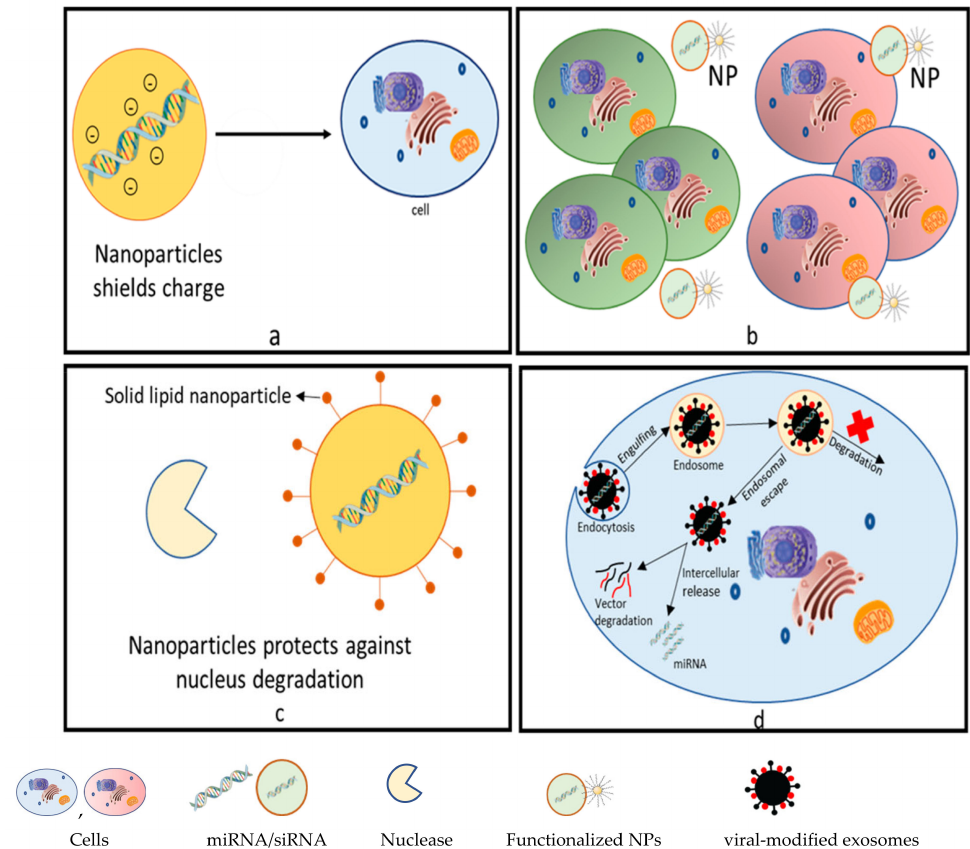
Figure 5. Illustration of dendritic molecular structures with a central core, repeating branches, and terminal reactive functional groups. They can be classified as polymers and hyperbranched poly- Figure 6. Advantages of nanoparticles. ( a ) Nanoparticles (NPs) encapsulate miRNA/SiRNA, thus mers with convergent and divergent architectures, depending on their molecular nature weight. Their nanostructure provides dendrimer–drug conjugation via different interactions such as elec- shielding the charges and improving the penetration/uptake of cells. ( b ) Functionalized NPs (meso- trostatic and hydrophobic/hydrogen bonds or the capacity for drug encapsulation within the central porous silicon) enable controlled and cell-specific miRNA/siRNA delivery. ( c ) Solid lipid nanoparti- cavity and/or between the dendrons (branches). Adapted and modified from [87] under the Creative cles (SLN) protect miRNA/siRNA from degradation and provide high stability. ( d ) Virus-modified Commons license. exosome (combination of NPs) enables siRNA/miRNA delivery into target cells, improving target specificity and endosomal escape.